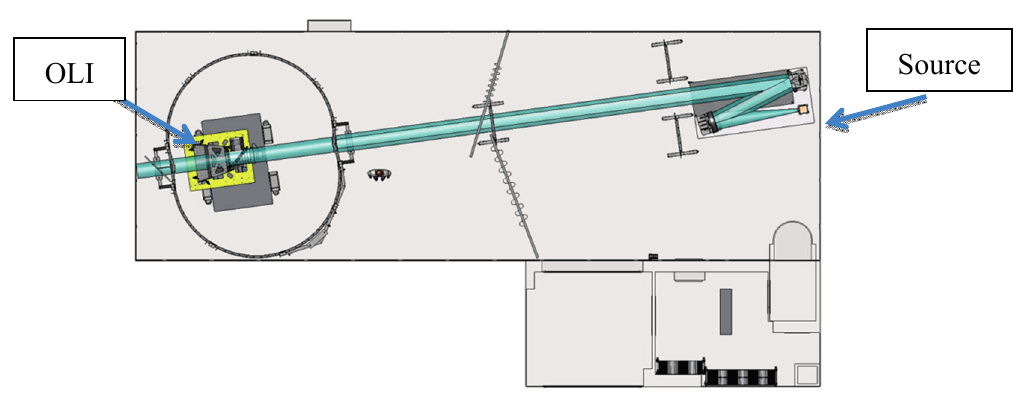
Figure 14. Stray light facility schematic. The instrument ( left ) sits inside extensive baffling around it and between it and the light source ( right ) to ensure that all stray light is from the instrument and not the